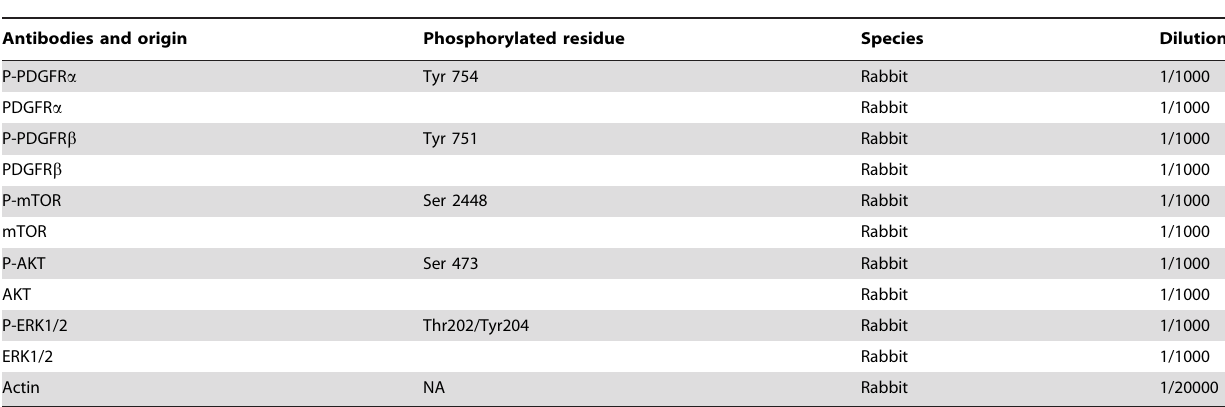
Table 1. Primary antibodies used for cell signaling